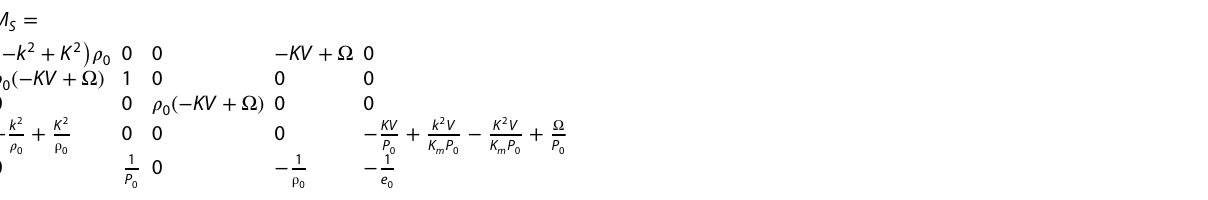
Table 1 The elements of the matrix defining the solutions’ structure in the